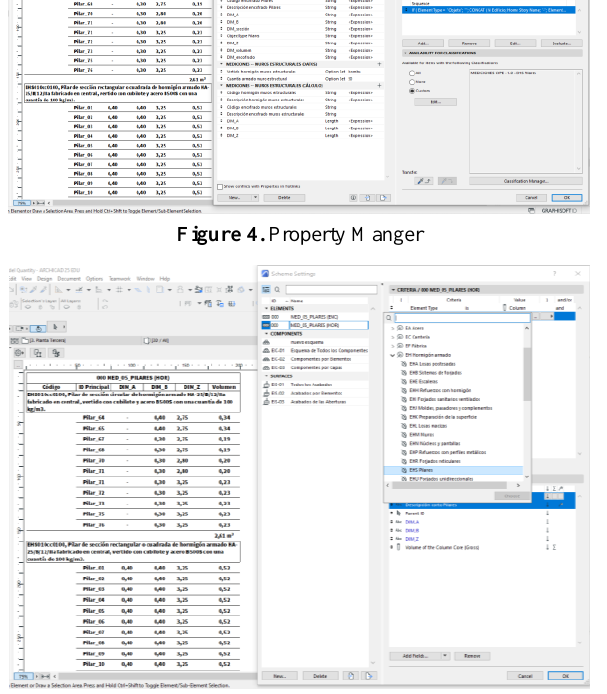
Figure 5. Sheme Settings for extraction of quantifications